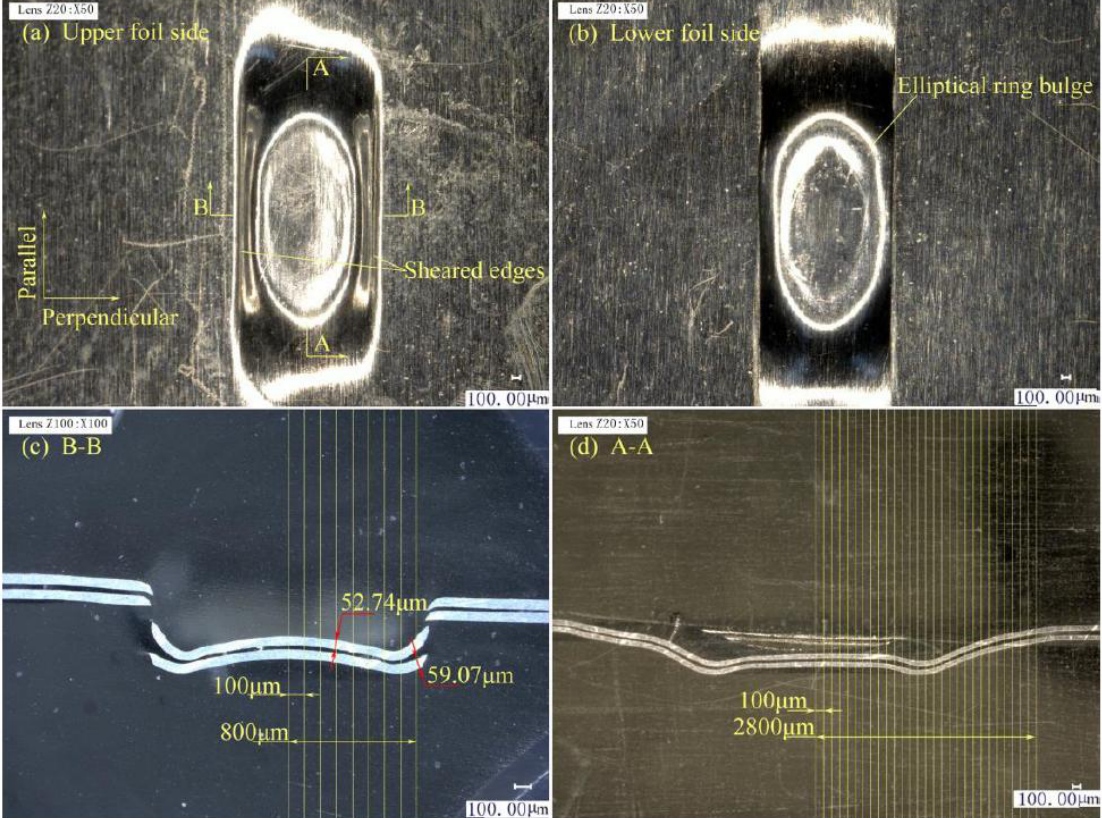
Figure 11. Preliminary joint formation in stage 1: ( a ) Upper foil side appearance; ( b ) Lower foil side appearance; ( c ) B–B section on perpendicular symmetry plane; ( d ) A–A section on parallel symmetry plane.